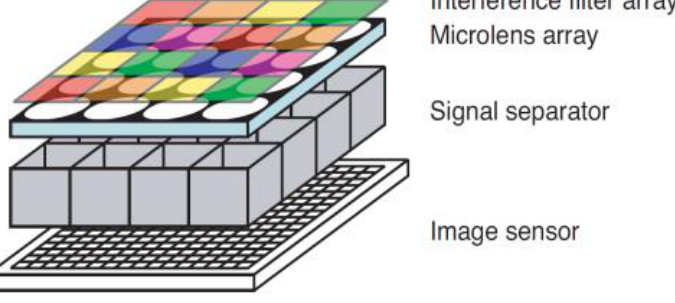
Figure 10. TOMBO system with different filters on each unit. The MLA used an orthogonal right-angle MLA (array positive orthogonal—APO) as the main imaging unit, model APO-Q-P500-AF1.3, composed of quartz glass with a lens spacing of 500 µ m, 1.3 mm, and a lens diameter of 500 µ m. Figure 11 presents the structural diagram of this series of MLA [41].